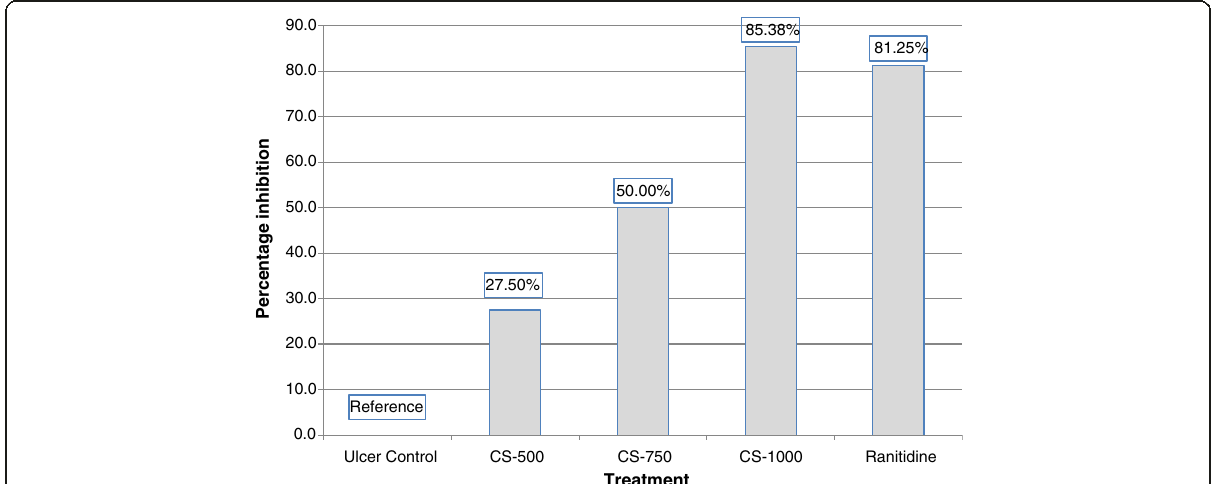
Figure 1 Effect of C. sieberiana (CS) root bark extract on gastric ulcer inhibition in F 344